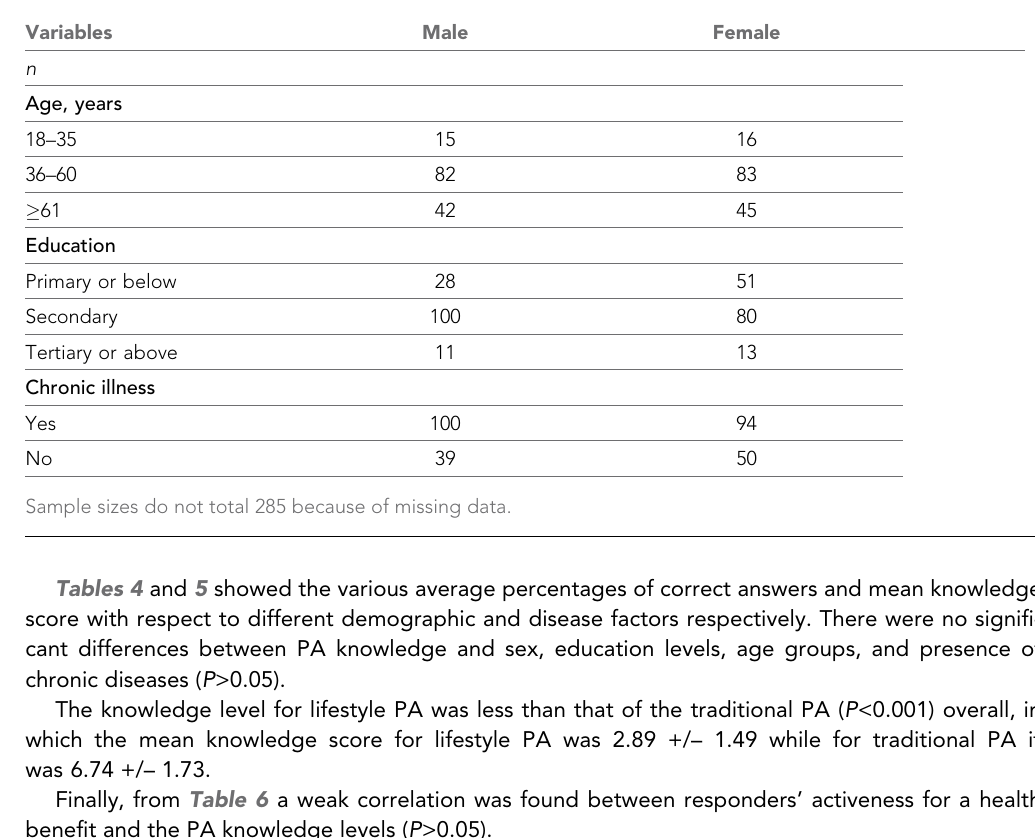
Table 1. Descriptive statistic of responders ( n =